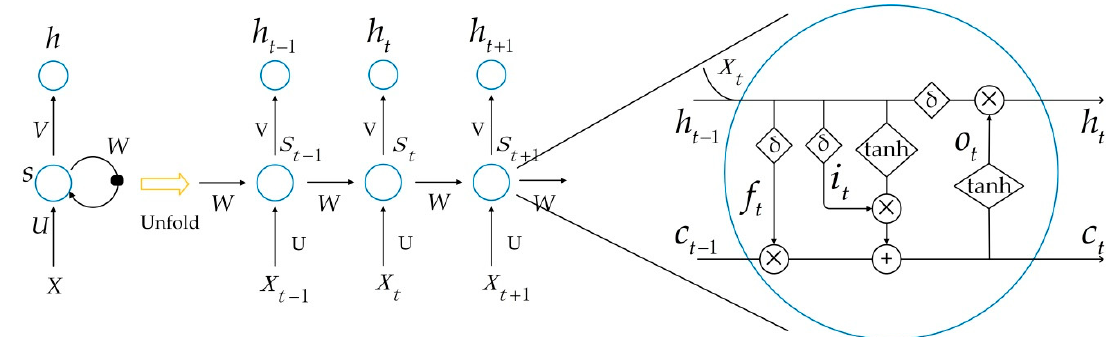
Figure 2. Basic structure of an LSTM. 𝑆 𝑡 represents the memory at time t, U represents the weight of the input layer to the hidden layer, W represents the weight of the hidden layer to the hidden layer and V represents the weight of the hidden layer to the output layer.